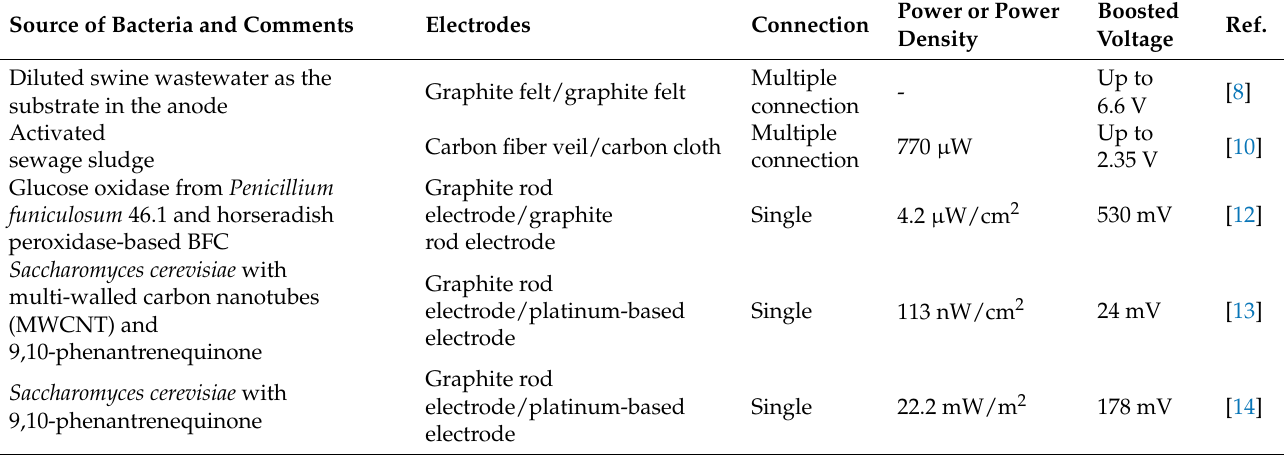
Table 1. Comparison of different biofuel